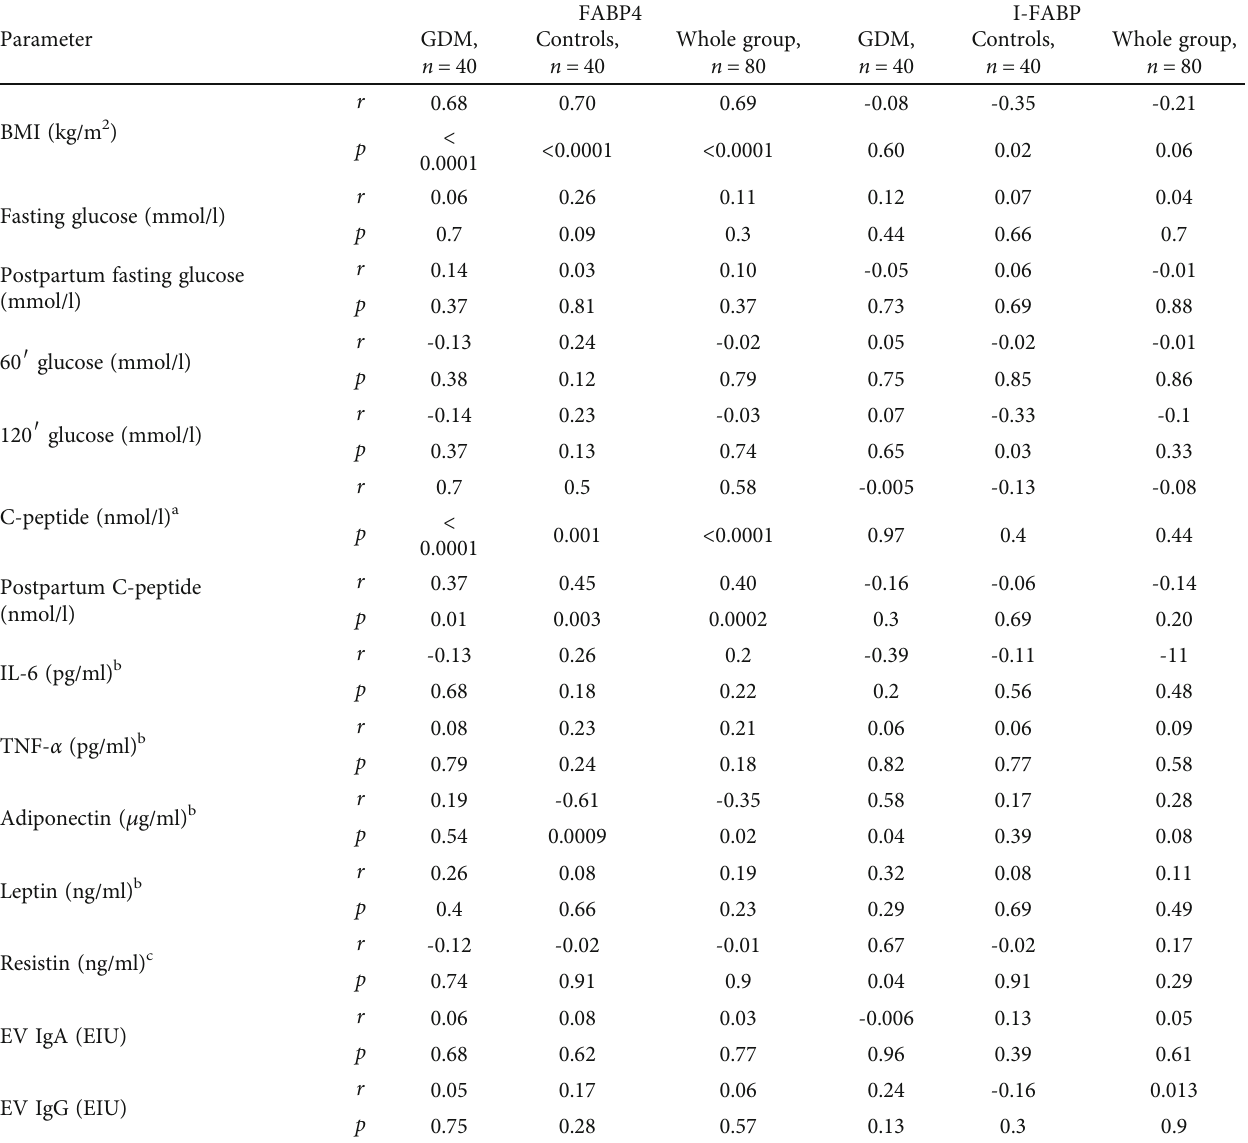
Table 2: Spearman correlations of FABP4 and I-FABP levels with other